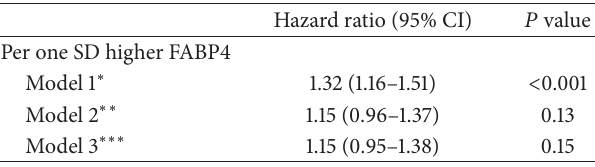
Table 2: Hazard ratio (95% CI) of SCD per each SD (18.98ng/mL) increase of FABP4 concentration among CHS participants ( 𝑛 = 4560 ).